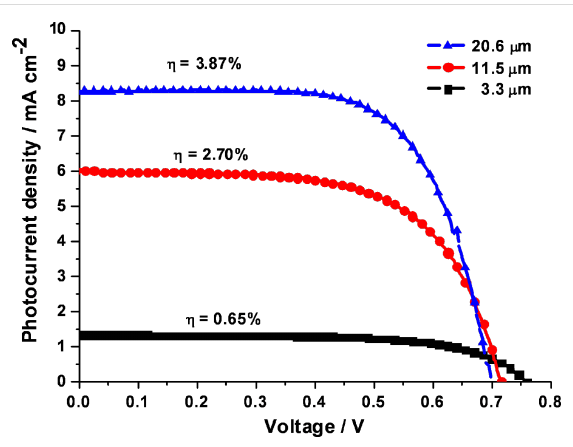
Figure 2: Photocurrent–voltage characteristics of N719-DSSCs fabri- cated by using 3.3 μ m, 11.5 μ m, and 20.6 μ m TNT arrays under an AM 1.5 solar simulator (100 mW·cm − 2 ).